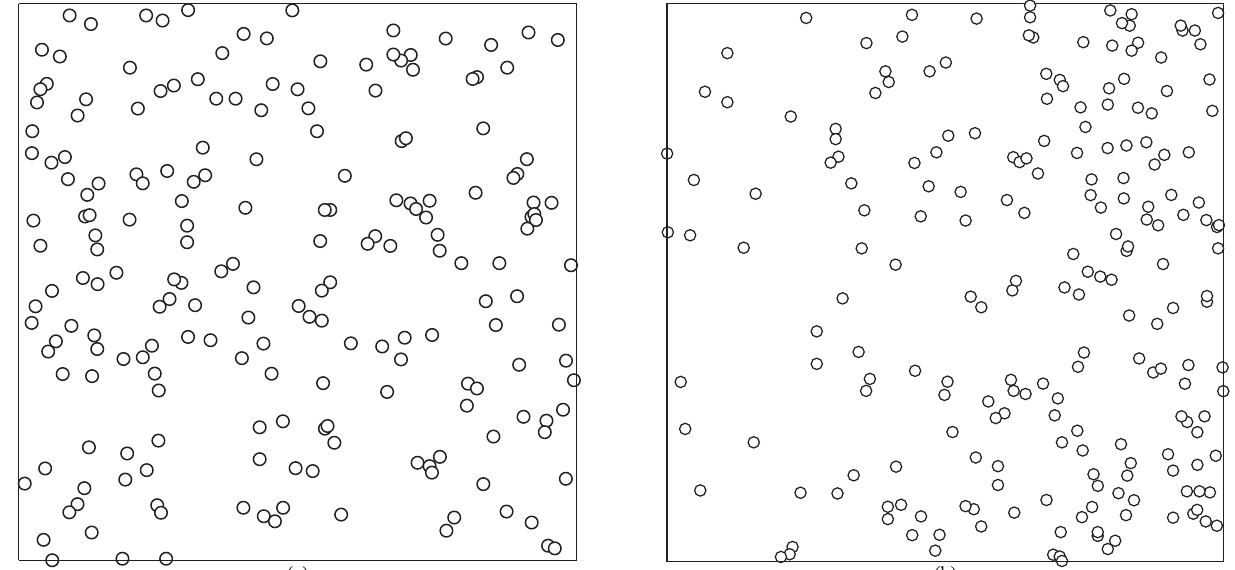
Figure 1. Computer simulation of point processes in a square area with horizontal axis x = 0 to x = 1 and vertical axis x = 0 to x = 1. Figure show homogene- 1 1 2 2 ous Poisson point process (1a) with intensity equal to 200 points per unit area and inhomogeneous Poisson point process (1b) with intensity varying linearly along the horizontal axis ( x ) according to 350 x + 25. Notice that for x = 0.5 the intensity of the inhomogeneous process is the same (200) as that of the 1 1 1 homogeneous process. Simulations were performed using the R